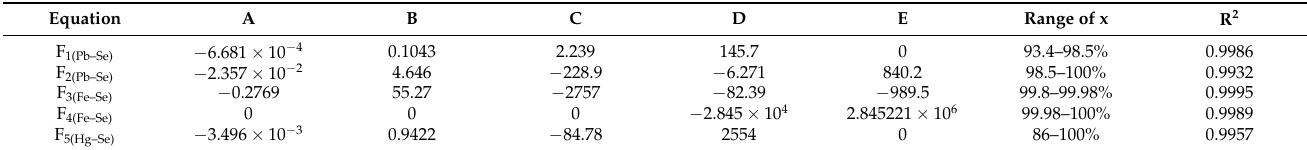
Figure 3. The liquidus curves used to fit: ( a ) Pb–Se system; ( b ) Fe–Se system and ( c ) Hg–Se system. Table 2. The parameters of polynomial equations for Pb–Se, Fe–Se and Hg–Se systems.